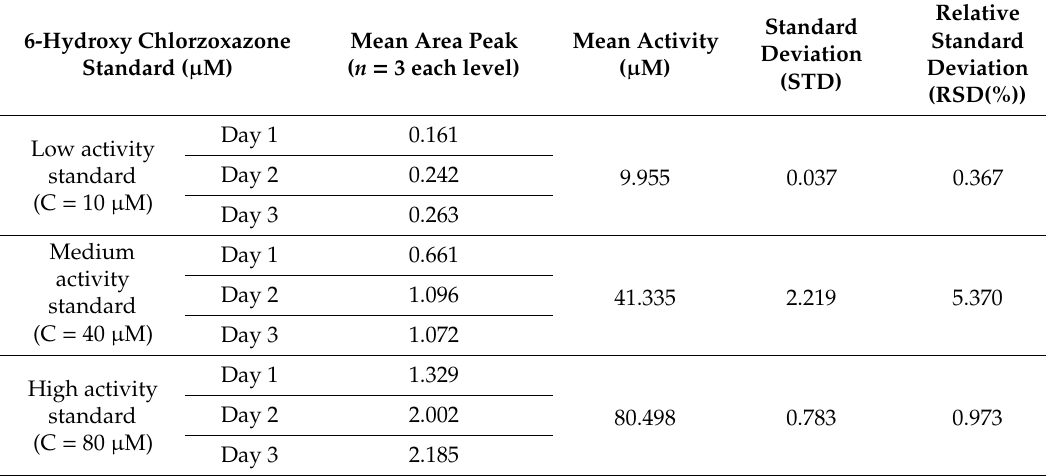
Table 6. Inter-assay performance of